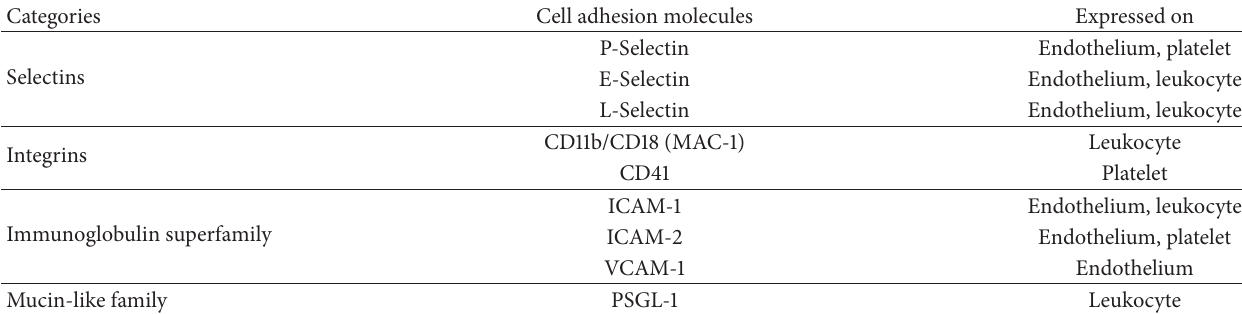
Table 1: Major cell adhesion molecules (CAMs) involved in neutrophils